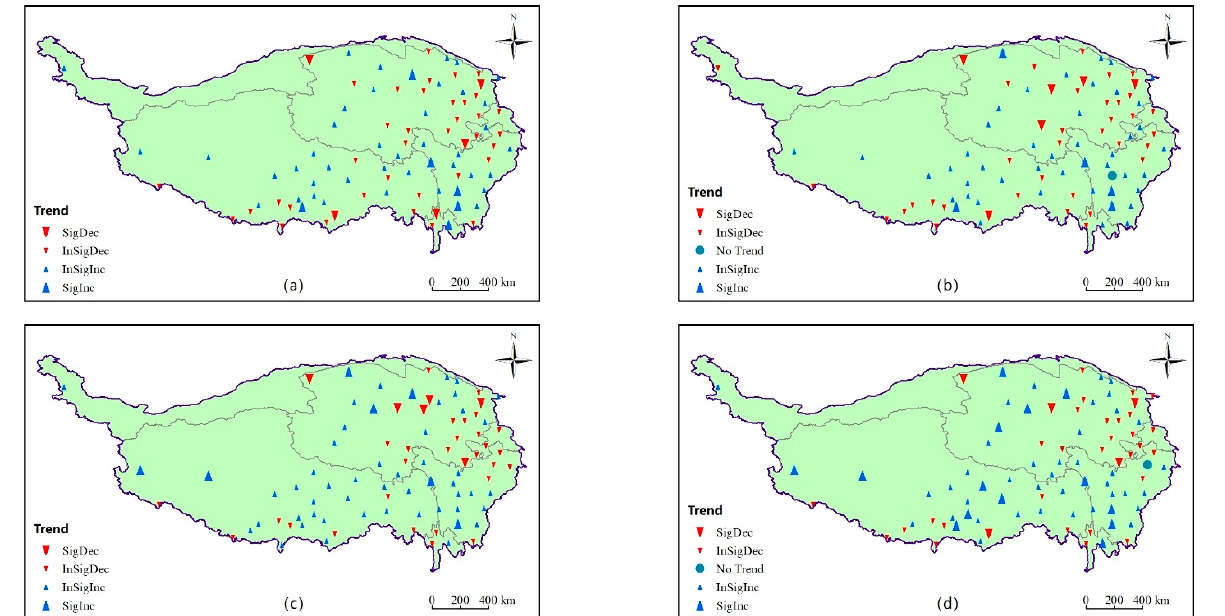
Figure 13. Spatial trend distribution of the SPEI at different timescales on the TP in 1966–2016. ( a ) SPEI-1, ( b ) SPEI-3, ( c ) SPEI-6, ( d ) SPEI-12.